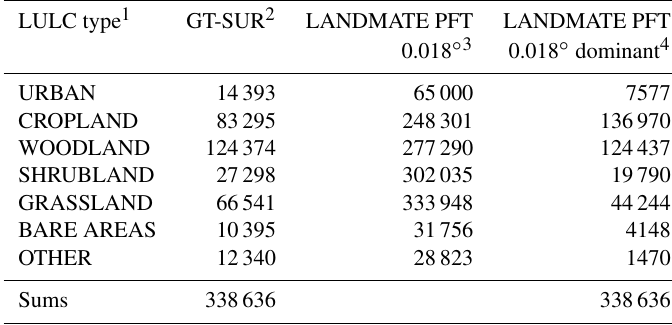
Table 6. General information on data in the